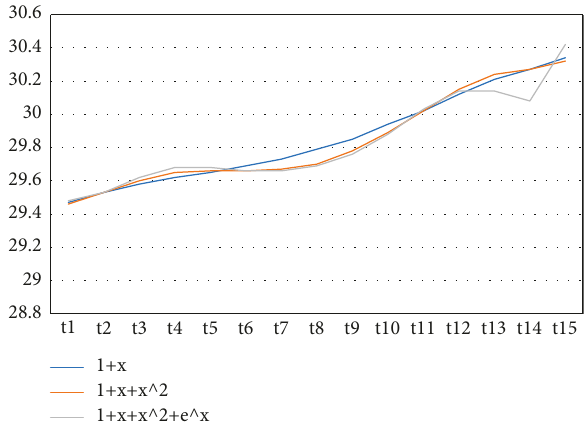
Figure 7: Error method to simulate the curve.